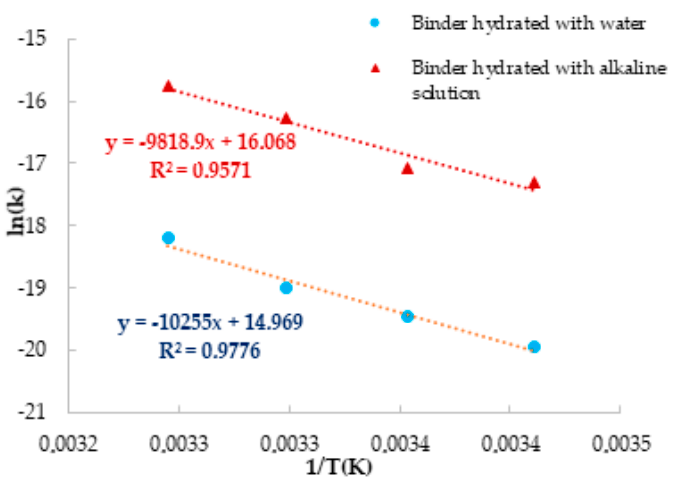
Figure 3. Graphic representation of ln(k) in function of 1/T for the temperatures 20, 25, 30, and 35 °C. The blue dots correspond to the pastes hydrated with water, while the red triangle corresponds to the alkali-activated pastes. The best fit is showed as dashed lines.